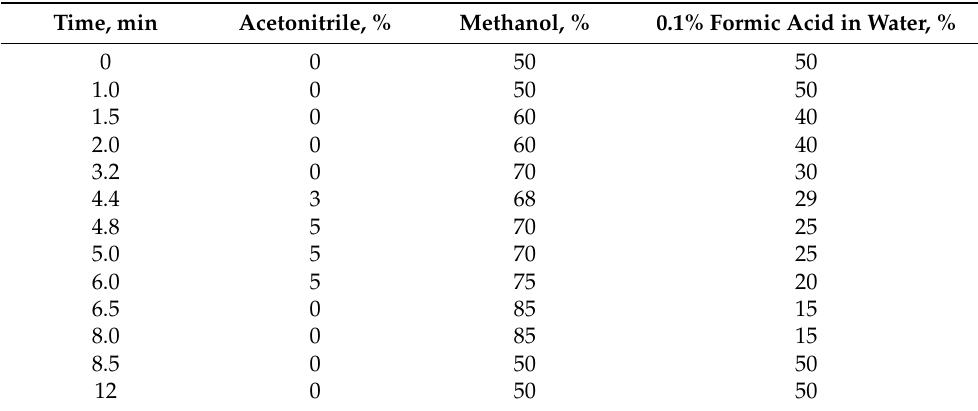
Table A1. Gradient separation